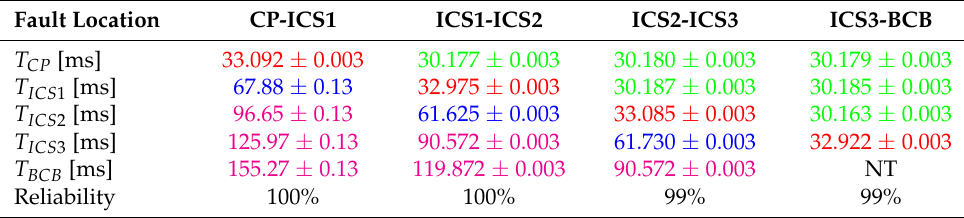
Table 5. Results obtained with SF = 7 and BW = 125 kHz.